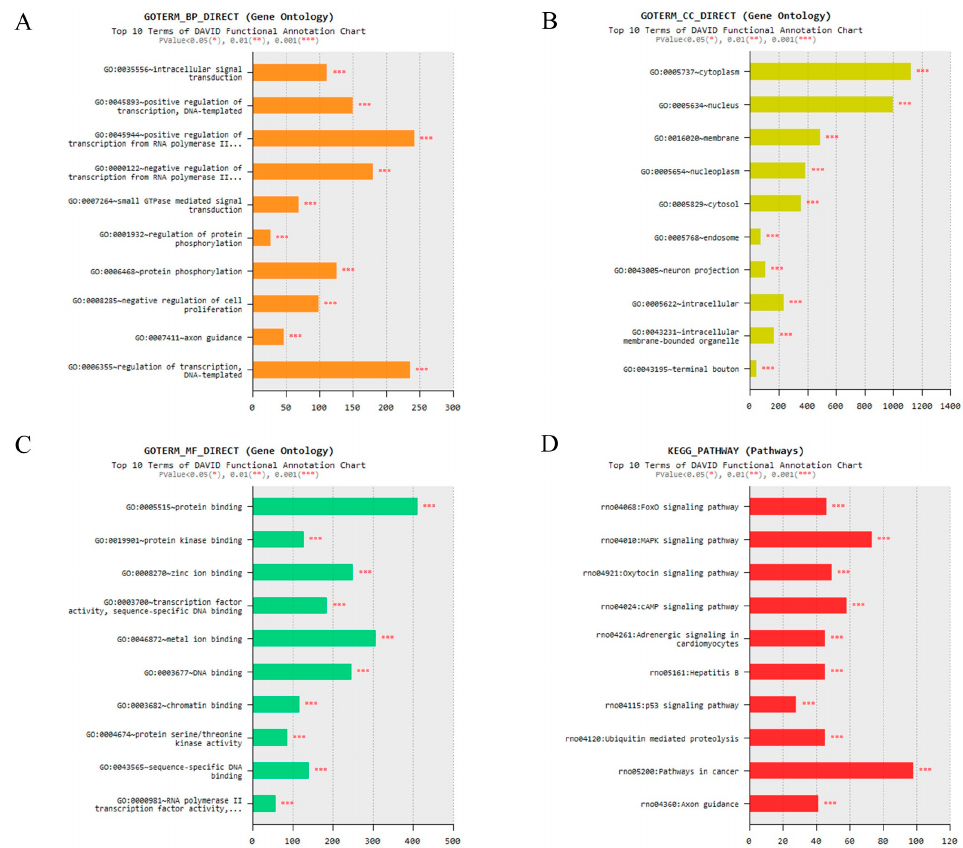
Figure 7. Gene ontology (GO) analysis and Kyoto Encyclopedia of Genes and Genomes (KEGG) pathway analysis indicating that neuronal exosomal miRNAs with different expression patterns under acute severe stress regulate neuron-related genes. ( A – C ) Bar graph represents the top 10 GO terms in the three categories: biological process (BP), cell component (CC), and molecular function (MF). ( D ) The most significant 10 KEGG pathways are displayed. * p < 0.05, ** p < 0.01 and *** p <